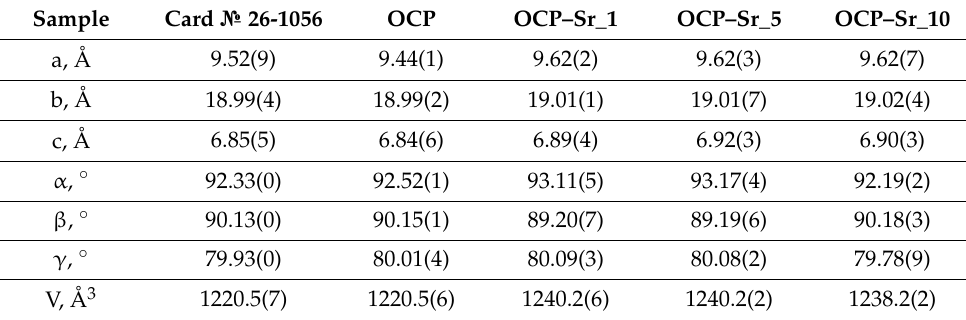
Figure 1. Powder X-ray diffraction patterns of the powder samples OCP and OCP-Sr. Table 1. Elementary cells parameters values. Standard deviations in parentheses.